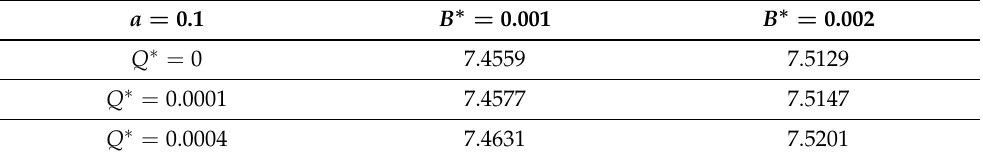
Table 2. Radii R of stable circular orbits. The related parameters are the same as those in Figure